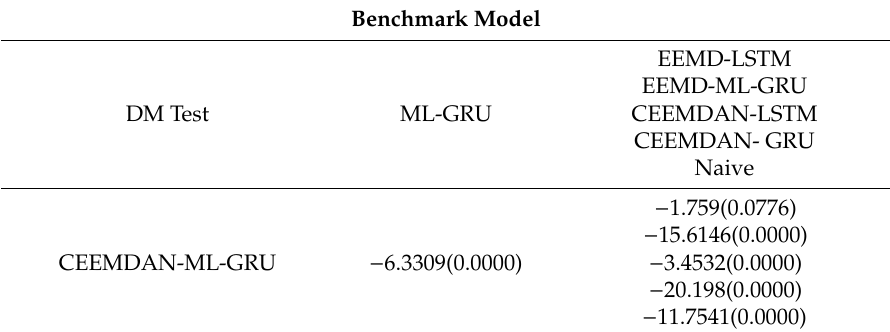
Table 7. The Diebold–Mariano (DM) test results for hybrid models on WTI crude oil